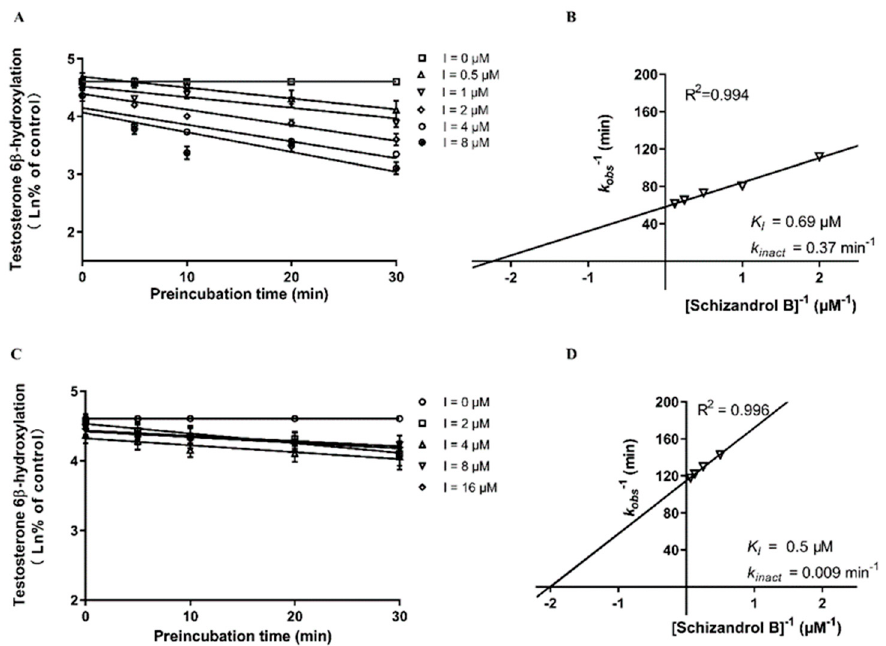
Figure 5. Dixon plots of SZB on CYP3A4 ( A , B ) and CYP3A5 ( C , D ) inactivation in genotyped HLMs. Various concentrations of SZB (0, 0.5, 1, 2, 4, 8 µ M for CYP3A4 and 0, 2, 4, 8, 16 µ M for CYP3A5) were pre-incubated at 37 ◦ C for 0, 5, 10, 20 and 30 min in 0.1 M PBS. ( A , C ) were plotted with the log of the percentage of control activity versus preincubation time. ( B , D ) were plotted with the half-life of enzyme inactivation versus the inverse of the SZB concentration. Each point represents the mean of triplicate experiments.